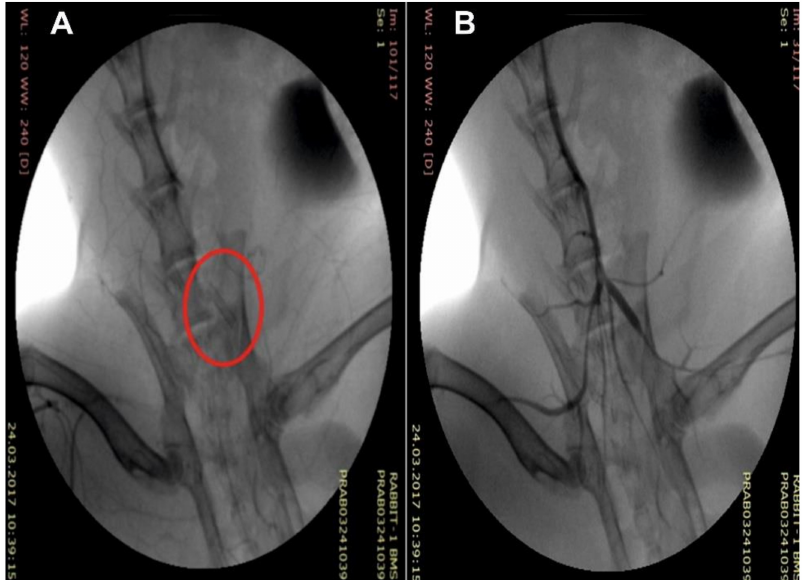
Figure 3. Intraoperational view of the stent with tissue engineered coating (C arm): ( A ) an implanted stent and ( B ) its angiographic